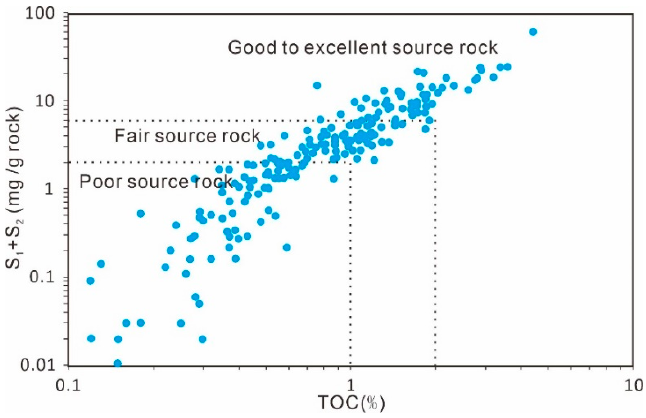
Figure 3. Crossplot of TOC and S 1 + S 2 of the Permian Fengcheng Formation source rocks.